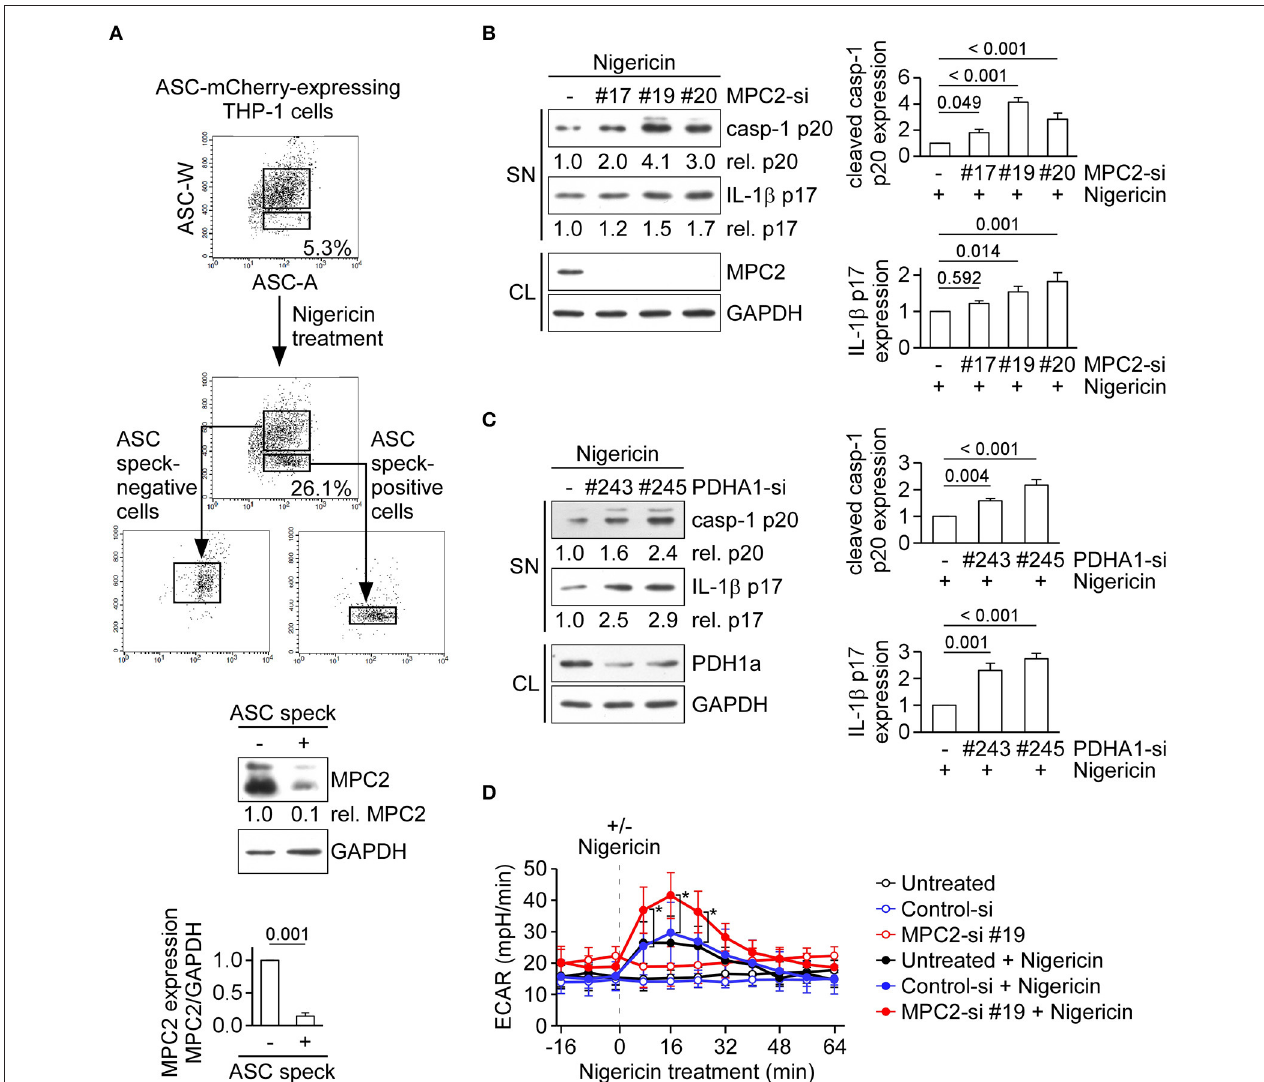
FIGURE 3 | Inhibition of the pyruvate oxidation pathway augments lactate production and enhances NLRP3 inflammasome activation. (A) ASC-mCherry-expressing THP-1-derived macrophages were treated with nigericin for 1h, ASC speck-containing cells were isolated by flow cytometry. Low and high ASC-W:ASC-A profiles were used, respectively, to indicate ASC speck-positive and -negative cells, and immunoblot was performed using anti-MPC2 and anti-GAPDH antibodies. The densitometric analysis of MPC2 was shown in the bottom panel. Results were analyzed with the Student’s t -test. (B) Immunoblot analysis of NLRP3 inflammasome molecules in cell supernatants and cell lysates of THP-1-derived macrophages treated with MPC2- or negative control siRNA, and then stimulated with nigericin for 45min. The densitometric analysis of caspase-1 (p20) and IL-1 β (p17) was shown in the right panel. (C) Immunoblot analysis of NLRP3 inflammasome molecules in cell supernatants and cell lysates of THP-1-derived macrophages treated with PDHA1- or negative control siRNA, and then stimulated with nigericin for 45min. The densitometric analysis of caspase-1 (p20) and IL-1 β (p17) was shown in the right panel. (D) ECAR of THP-1-derived macrophages that had been pretreated with or without MPC2- or negative control siRNA, following stimulation with or without nigericin (dotted vertical lines). All results are presented as the mean ± SD of data from three independent experiments ( n = 3 per group). Except for results of (A) , all results were analyzed with the ANOVA test followed by post hoc test. * P <